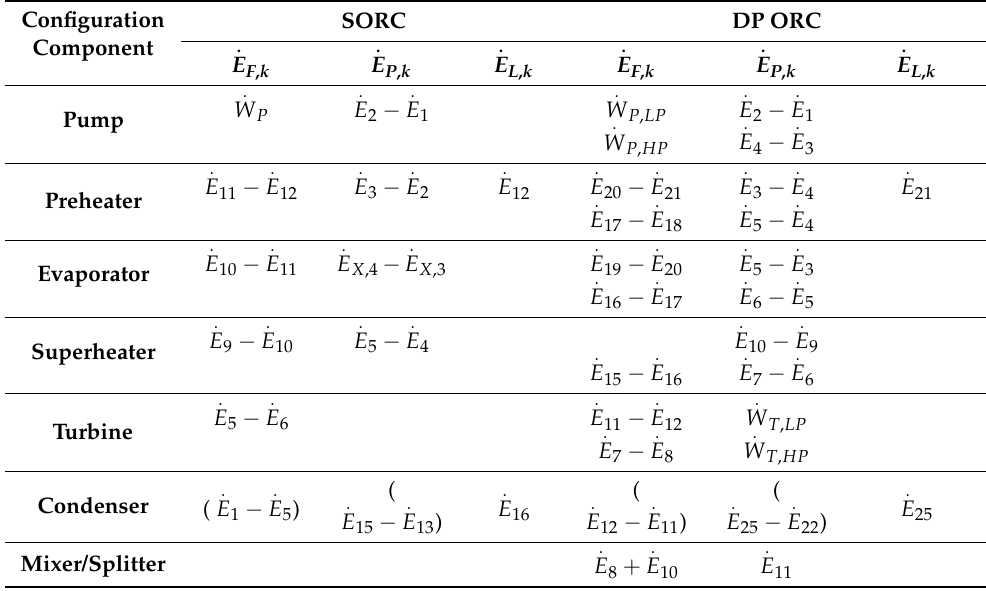
Table A3. The exergy relations used in the conventional exergy analysis for the SORC and DP ORC configurations.